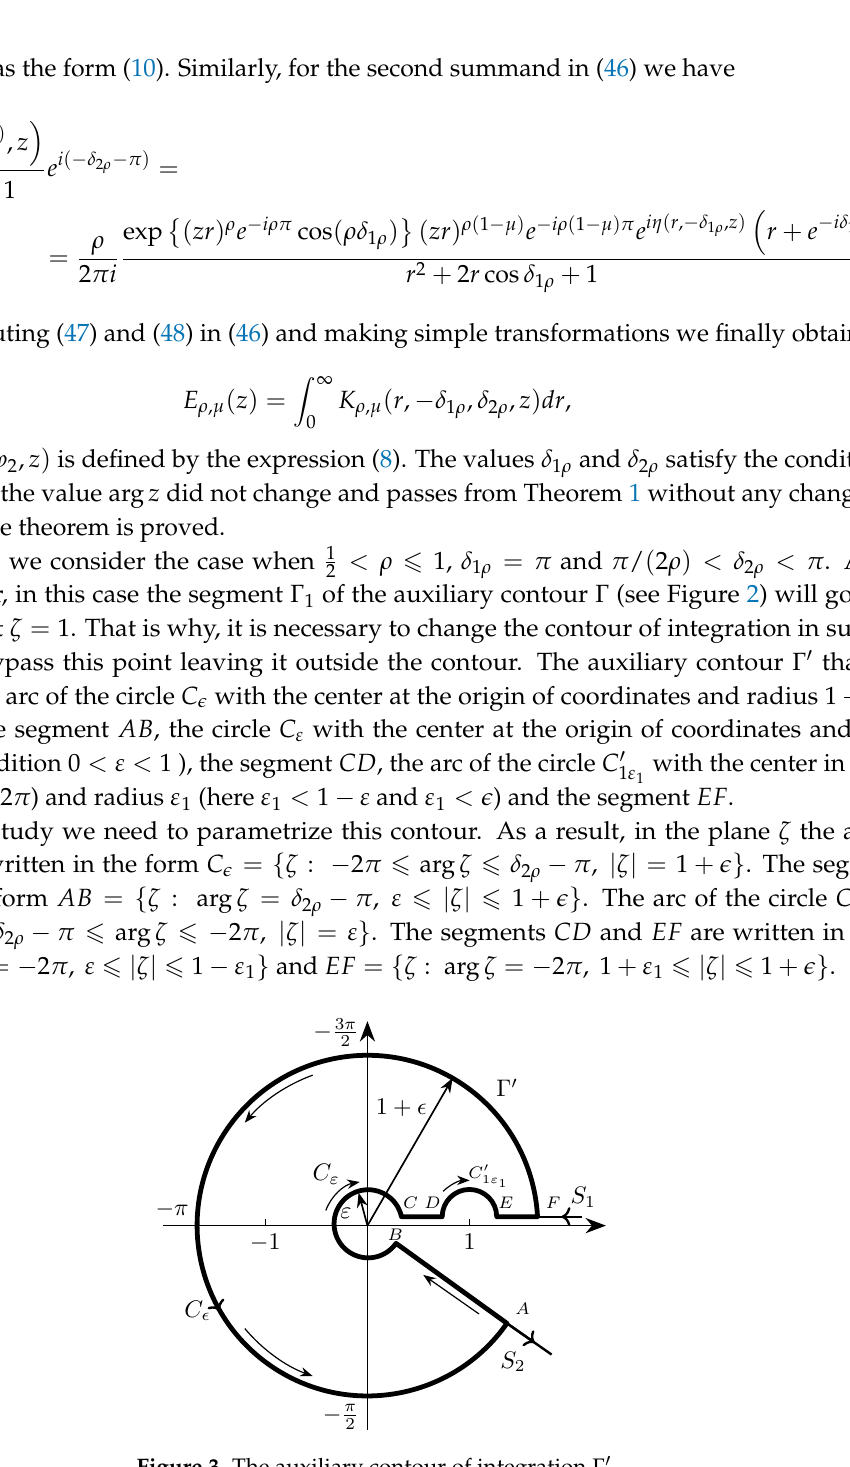
Figure 3. The auxiliary contour of integration Γ (cid:48)